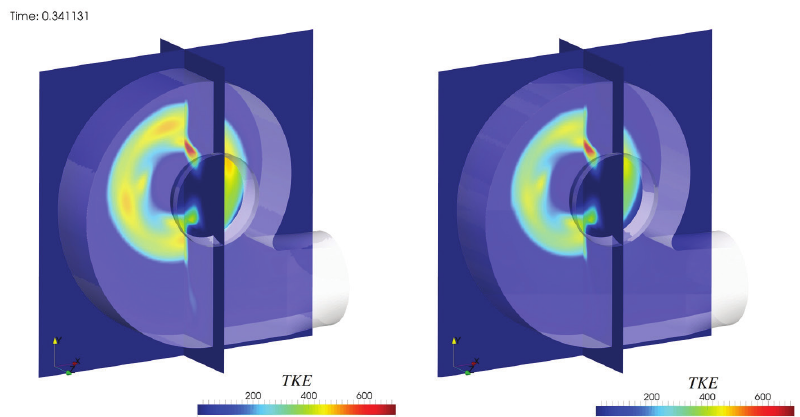
Figure 29 - Averaged field of turbulent kinetic energy; left: original rotor; right: modified